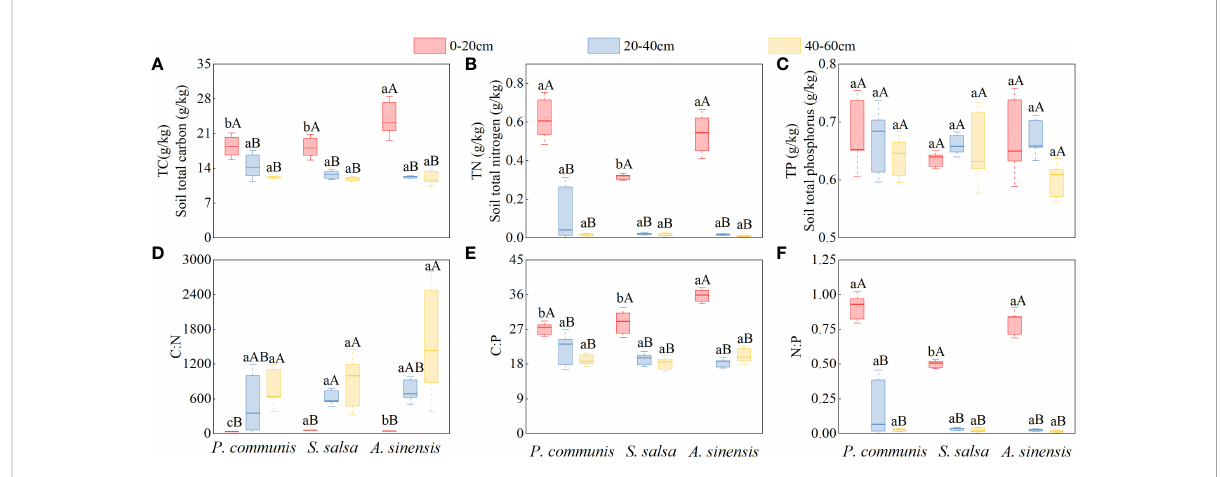
FIGURE 5 Halophytes characteristics of TC (A) , TN (B) and TP (C) contents and C:N (D) , C:P (E) and N:P (F) stoichiometric ratios in soils of different soil layers. Capital letters indicate the difference among different soil layers in the same halophyte, lowercase letters indicate the difference among different halophytes in the same soil layer ( P <